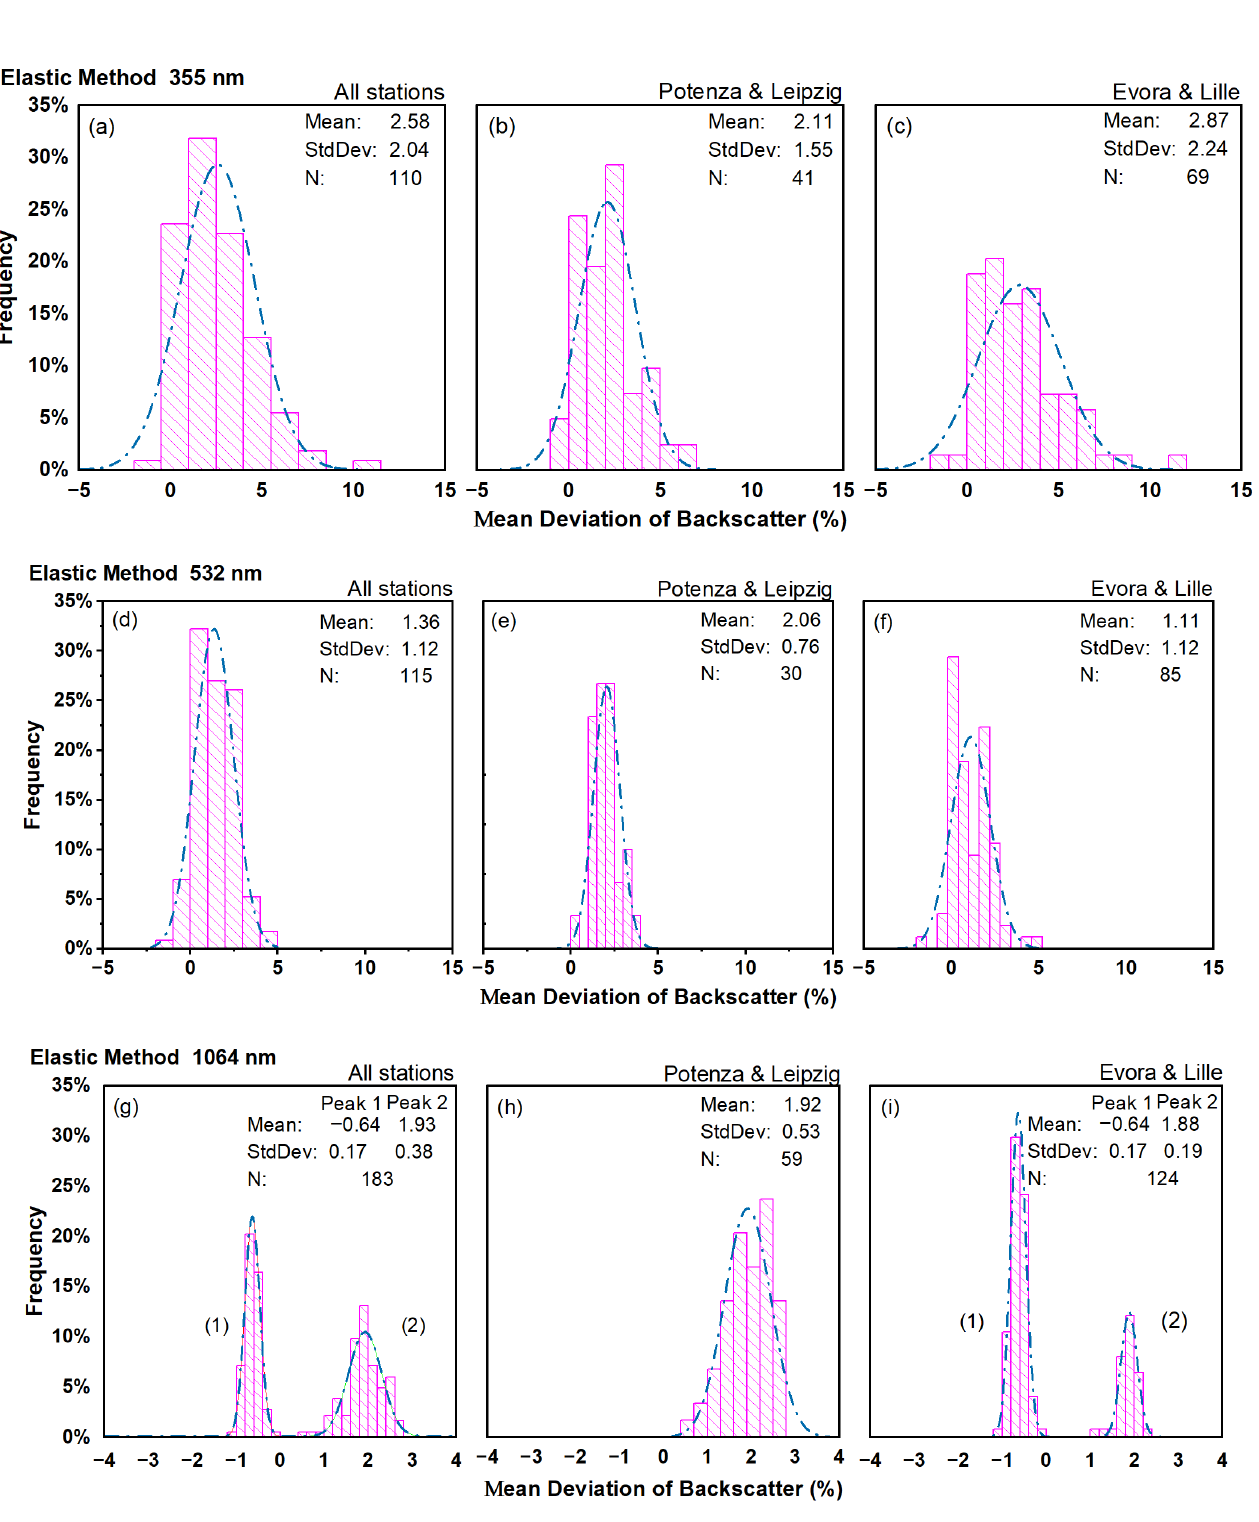
Figure 12. The frequency distributions of the mean relative deviation of elastic backscatter from all the cases at 355 nm, 532 nm, and 1064 nm ( a , d , g ), together with IFS_ECMWF vs. ERA5 (for Potenza and Leipzig stations) at three wavelengths ( b , e , h ) and GDAS vs. ERA5 (foe Evora and Lille stations) at the three wavelengths ( c , f , i ). The dotted line shown in the subfigure is the Gaussian fitting curve.